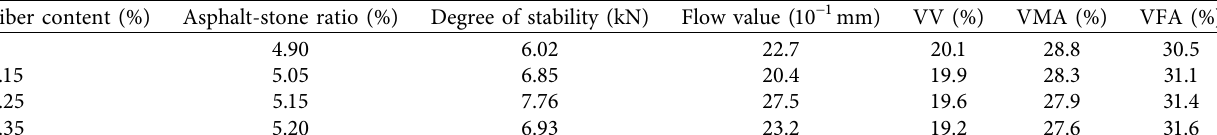
Table 10: Marshall test results of SBS asphalt mixture with different content of fiber.